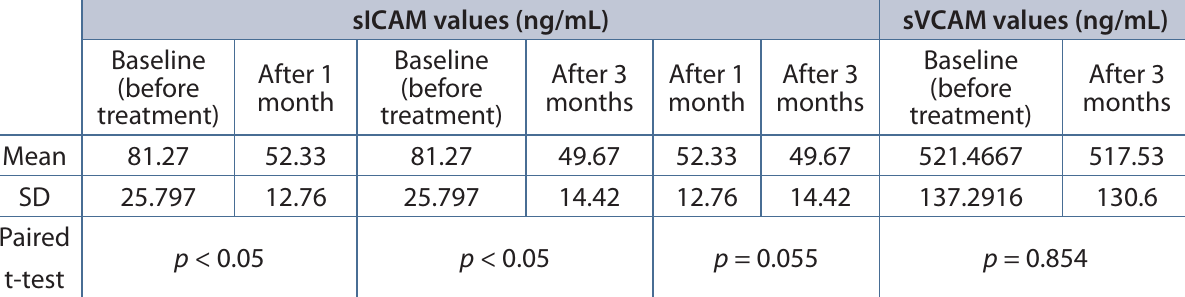
Mean SD Paired t-test